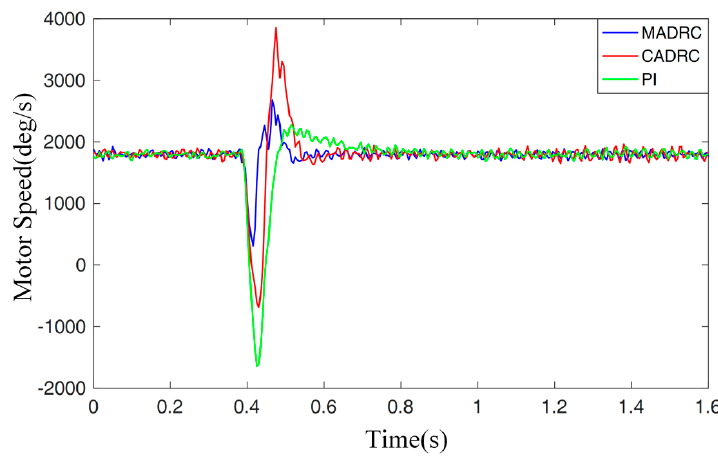
Figure 20. Speed loop step response curves. Owing to the torque motor limitation, only the constant 0.25 Nm load torque was tested. The